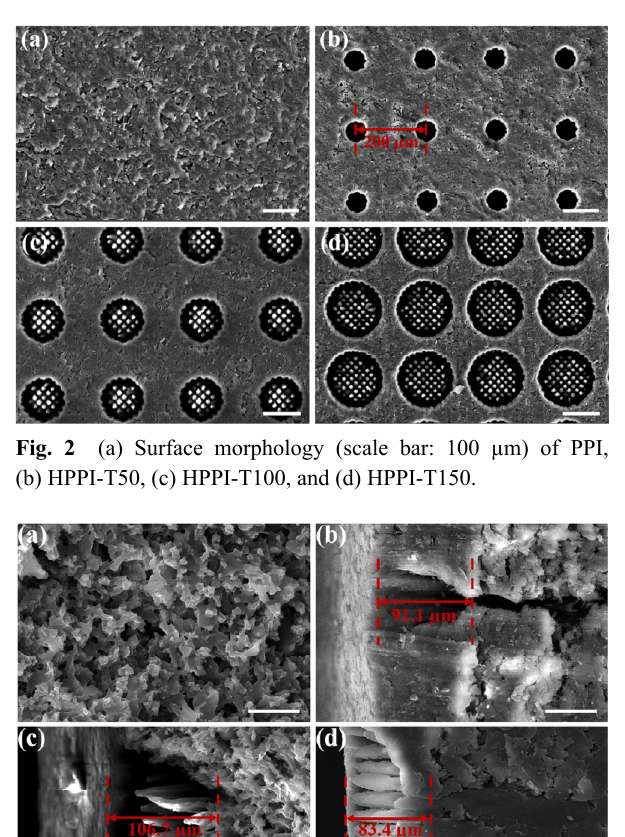
Fig. 1 (a) Mercury intrusion (black) and extrusion (red) curve, and (b) the pore size distribution of PPI based on mercury intrusion